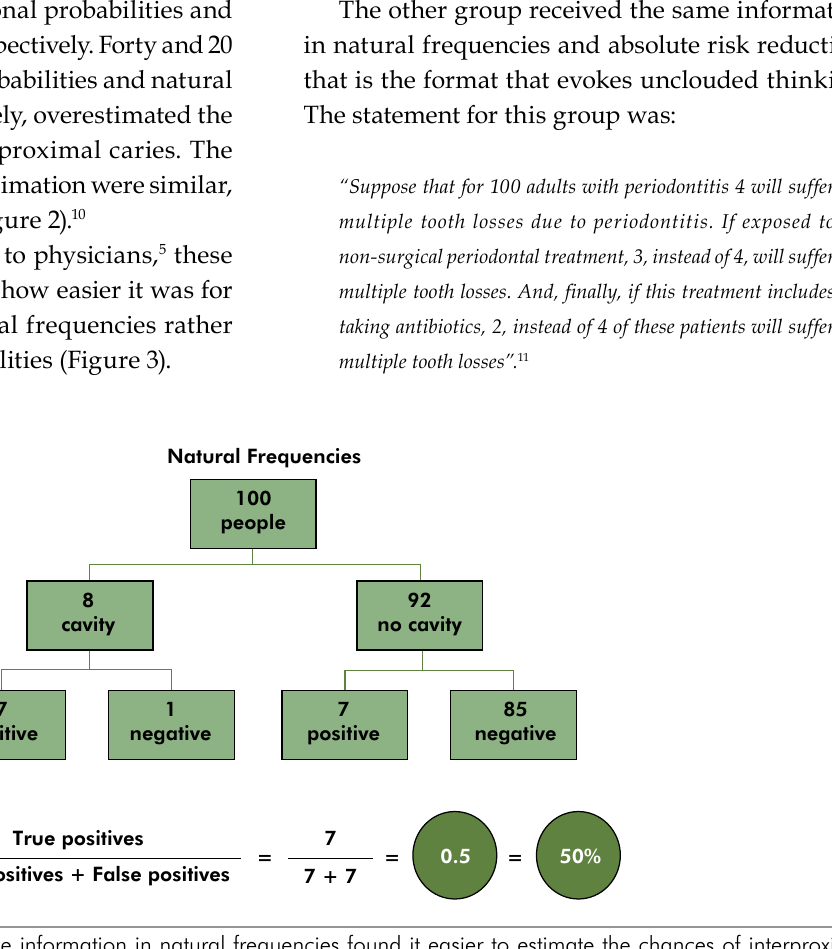
Figure 1. Dentists who received the information in natural frequencies found it easier to estimate the chances of interproximal caries given a positive bitewing radiograph. The reason is that they had to pay attention only to two numbers: the number of adults with a positive bitewing radiograph and caries (7) and the number of adults with a positive bitewing radiograph without caries (7). Adapted from Nadanovsky et al. 10 with